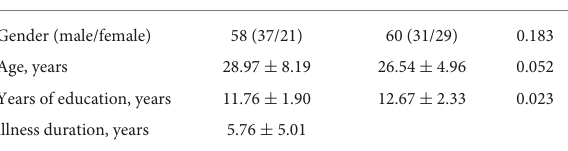
TABLE 1 The p -value for gender distribution was obtained by the chi-square